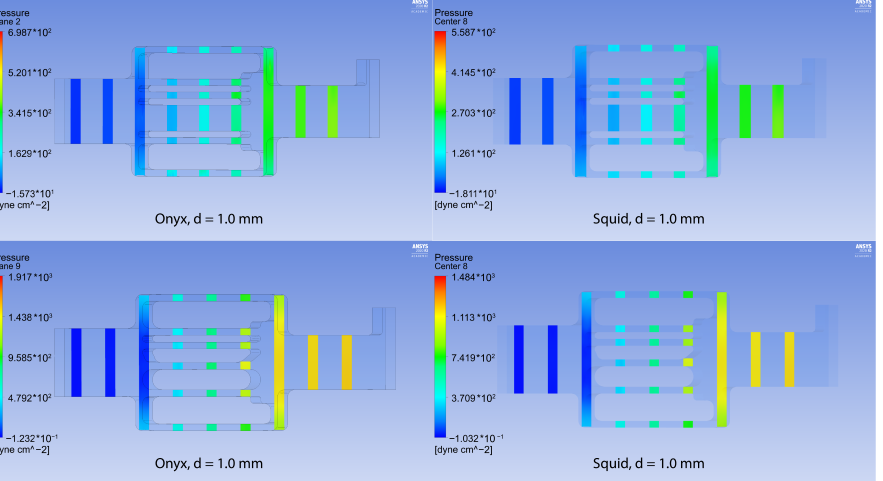
Figure 10. Pressure for the configurations with Onyx (cid:114) ( left column ) and Squid (cid:114) ( right column ) with fistula ( above ) and without it ( below ).